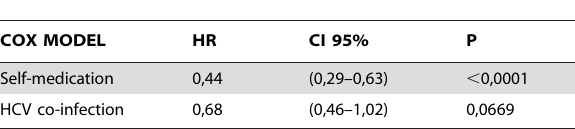
Table 2. Cox proportional hazard